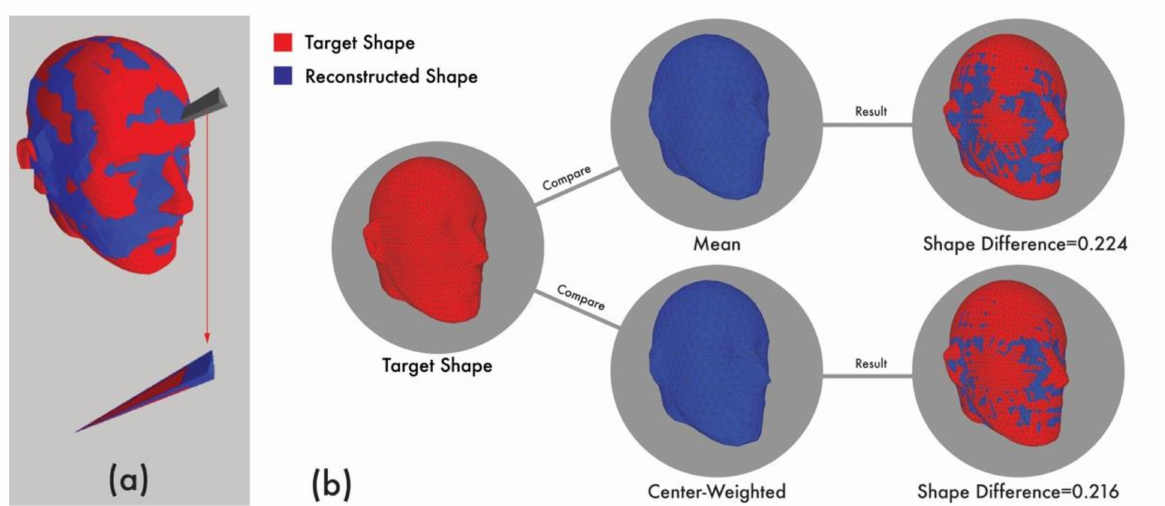
Figure 7. In the area corresponding to one side of the icosphere, ( a ) the difference in volume can be calculated by creating an intersection such as ( b ) that of the target shape (red) and the reconstructed shape